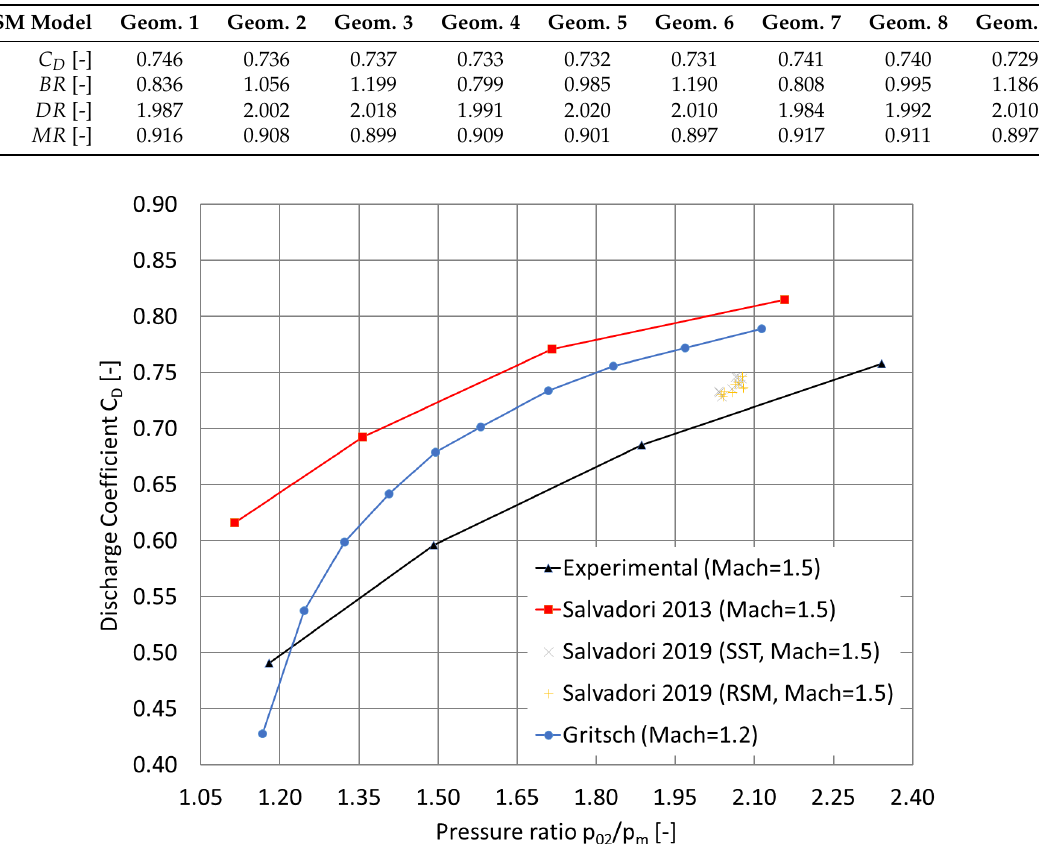
Table 3. Non-dimensional parameters for the film cooling configuration studied using the Reynolds Stress turbulence model.